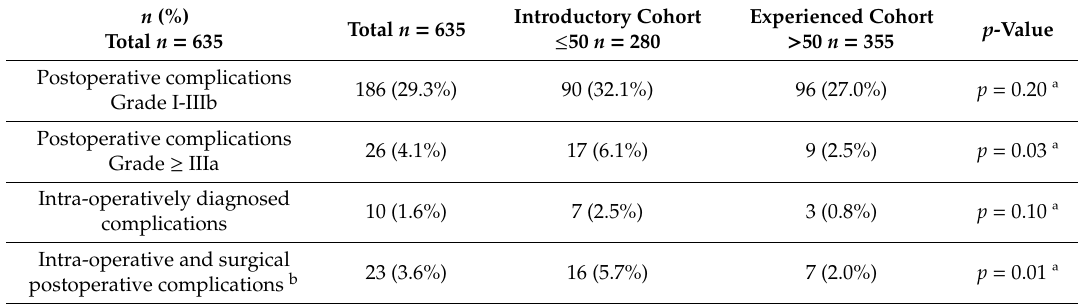
Table 2. Number and percentage of intraoperative and postoperative complications according to Clavien–Dindo in the introductory and experienced surgical cohort of robotic radical hysterectomy with and without radio chemotherapy in Sweden between December 2005 and June